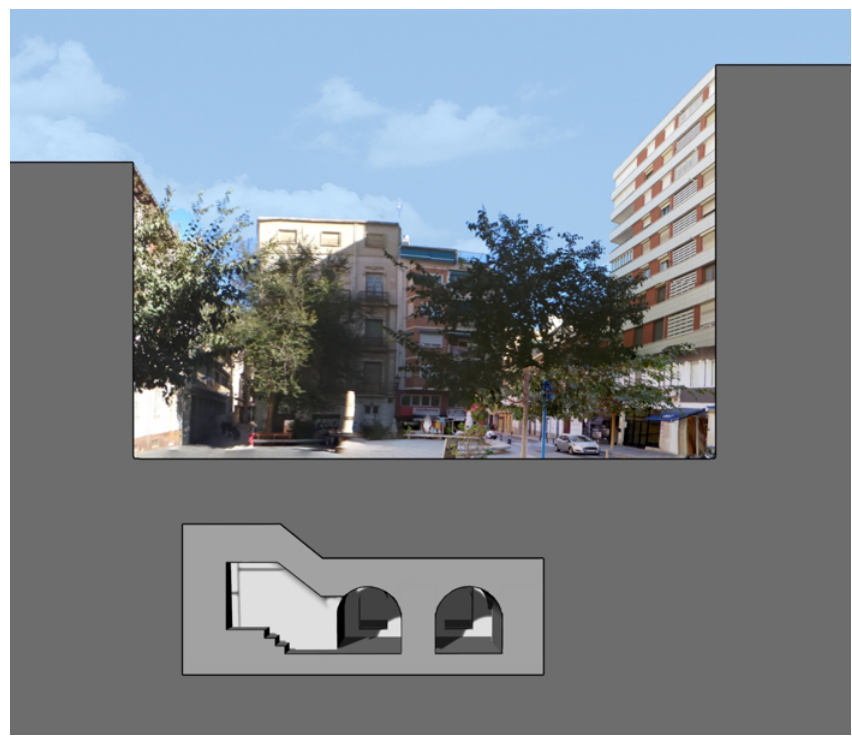
Figure 2. Photomontage of the Plaza Balmis section in its current state.